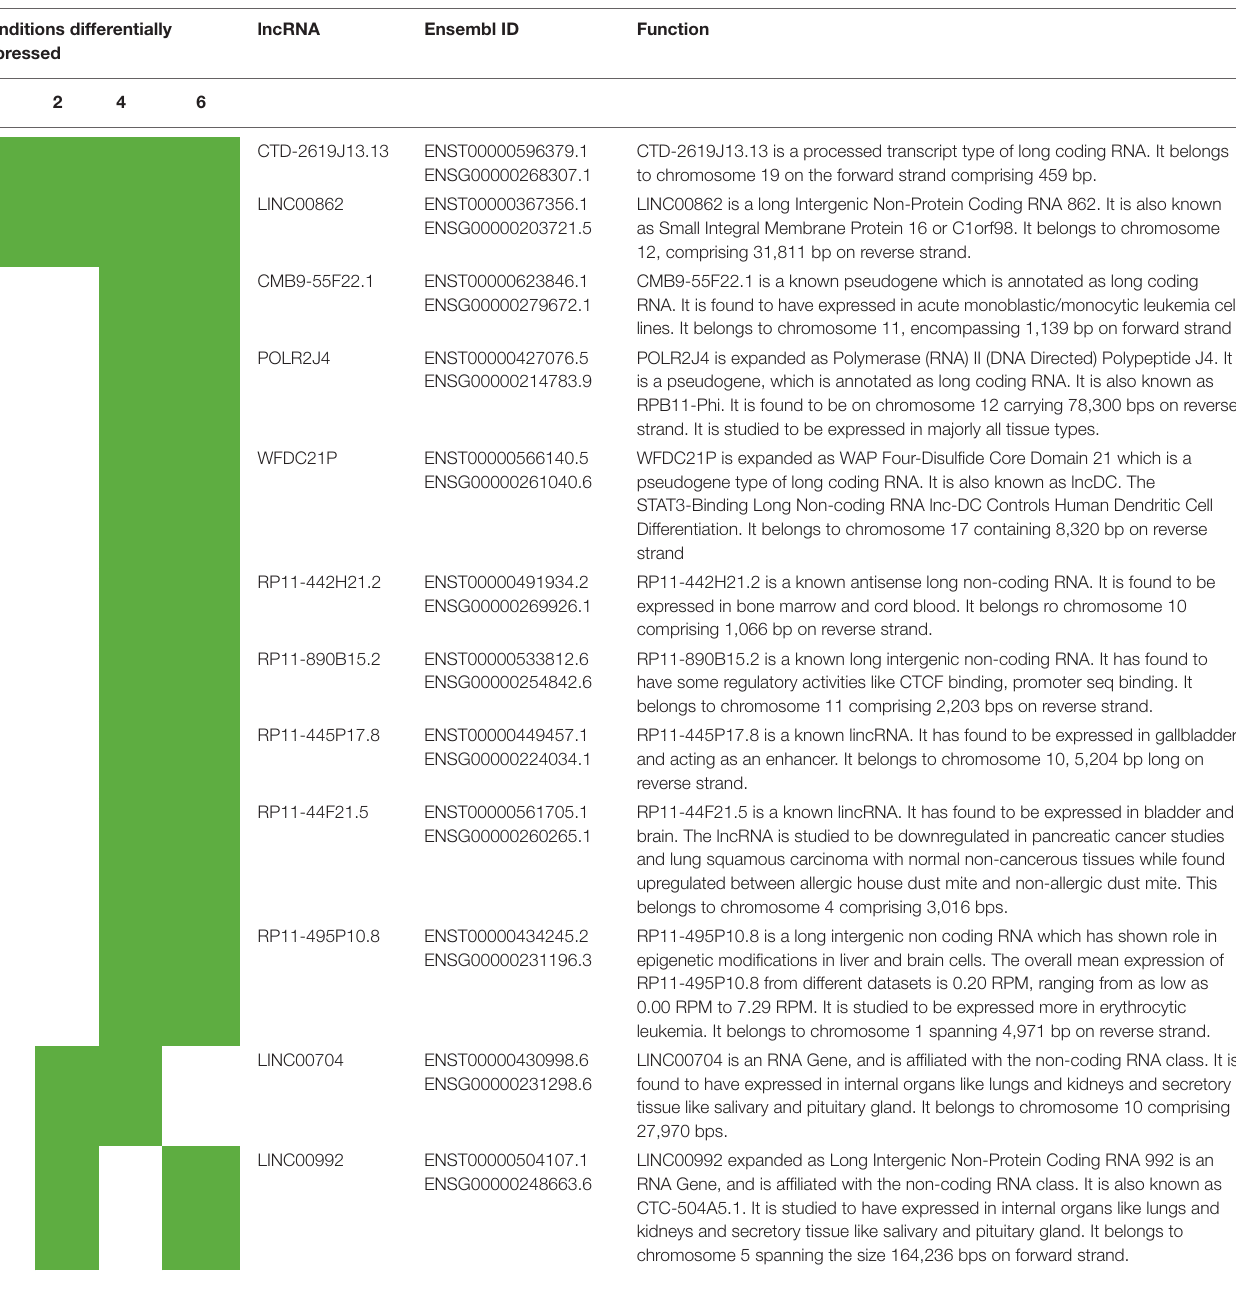
TABLE 2 | Summary of lncRNA genes differentially expressed in CF vs. non-CF cells for at least 2 of the time points of